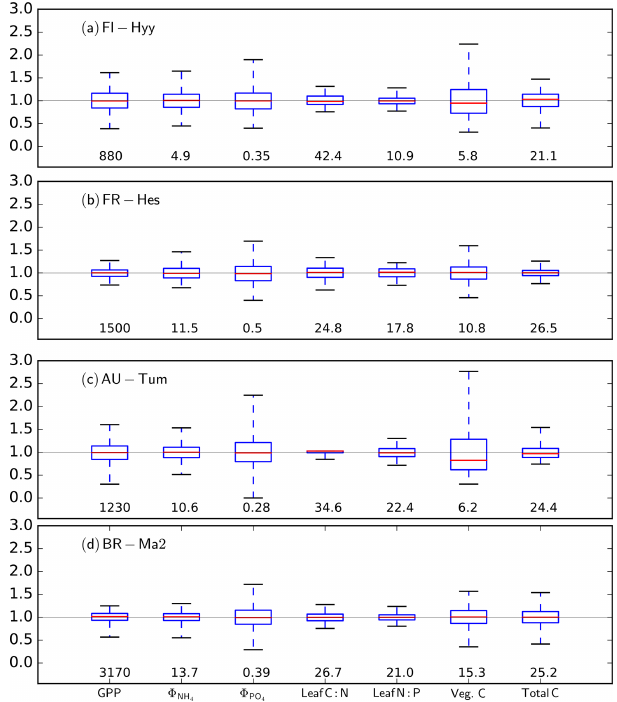
Figure 8. Median, interquartile range, and absolute range of simu- lated GPP, net mineralisation of NH 4 ( (cid:56) NH ) and PO 4 ( (cid:56) PO ), leaf 4 4 C : N and N : P, as well as vegetation C (veg. C) and total ecosys- tem C (up to a depth of 1m) obtained for the four FLUXNET sites in Fig. 3 using Latin hypercube sampling ( n = 1000) for 45 parameters. Values have been normalised to the ensemble mean, given as the number for each site and variable to improve readabil- ity. The numbers below each individual box correspond the median value for each variable: GPP in units gCm − 2 yr − 1 , (cid:56) NH in units 4 gNm − 2 yr − 1 , (cid:56) PO in units gPm − 2 yr − 1 , and vegetation and total 4 carbon in units kgCm − 2